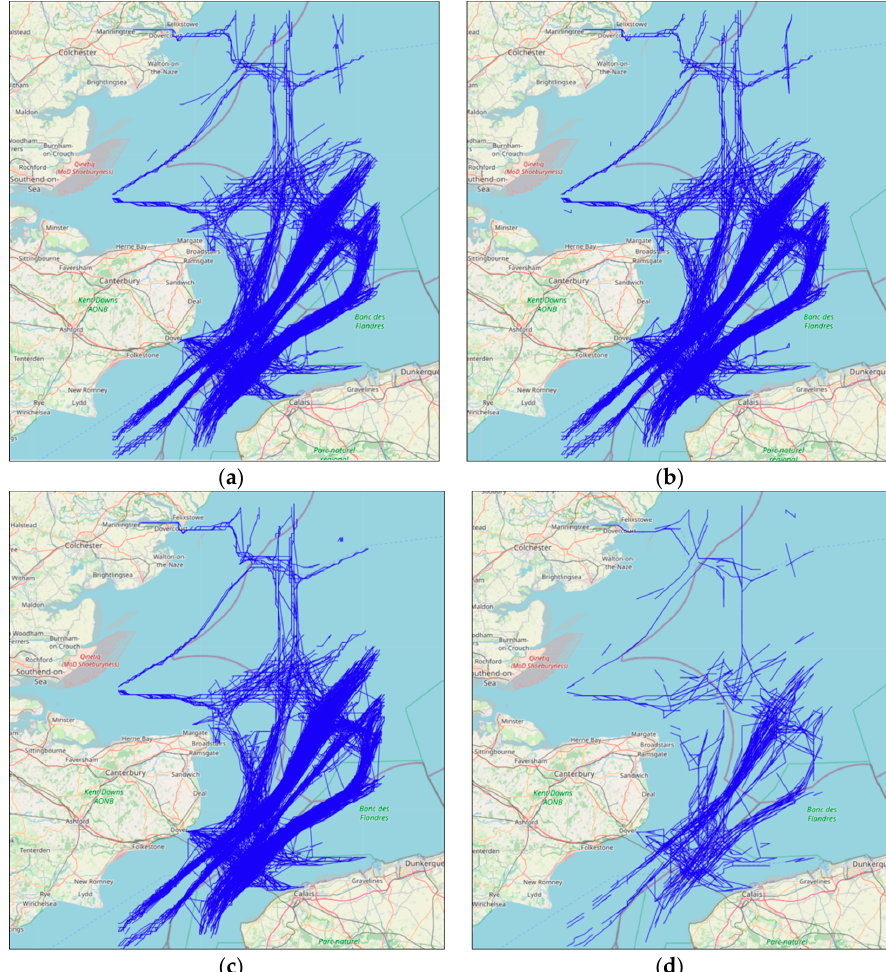
Figure 6. Visualisation of different kernel functions in the Arctic Ocean. ( a ) The original data; ( b ) the results with Gaussian convolution kernel; ( c ) the results with mean convolution kernel; ( d ) the results with sharpening convolution kernel.